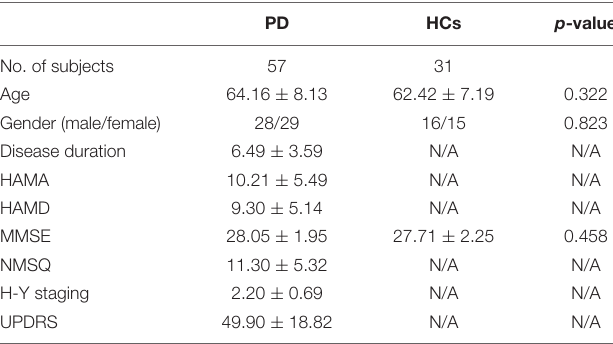
TABLE 1 | Clinical and demographic characteristics of the Parkinson’s disease (PD) patients and the healthy controls